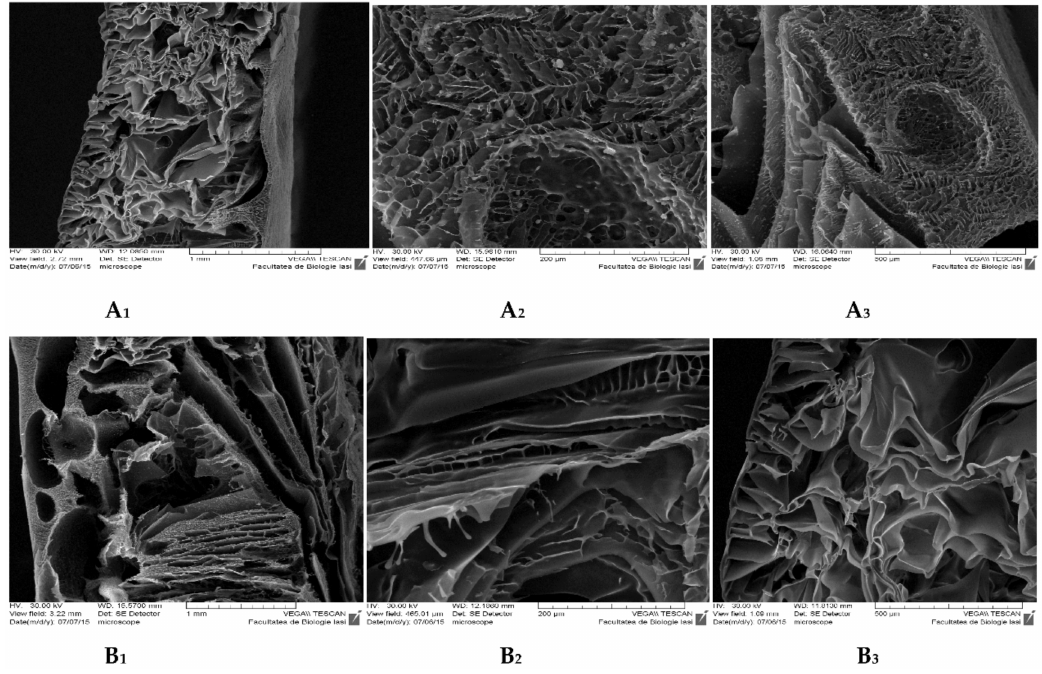
Figure 3. Scanning electron microscope (SEM) images for CS-PArg ( A 1 – A 3 ) and CS-6h ( B 1 – B 3 ) membranes at various magnifications of 1 mm, 200 µ m, 500 µ